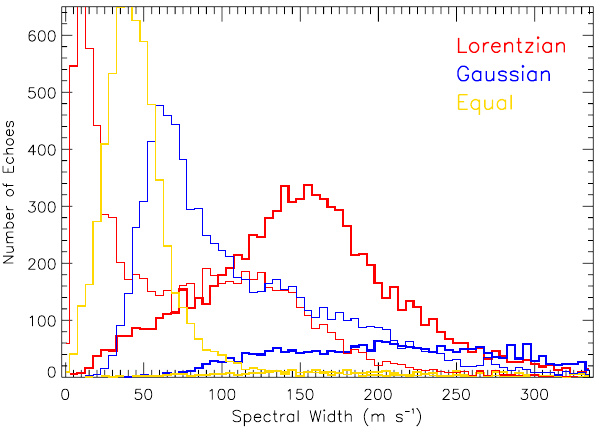
Fig. 4. Colour pixel maps showing the number of echoes versus 5-m s -1 bins of spectral width and for 45-km steps of group range relative to the location of the SWB during the interval, 12:15 to 15:00 UT on 10 December, 1999. The results have been sorted according to spectral fit type, (a) Lorentzian best fits, (b) indeterminate best fits, and (c) Gaussian best fits. The colour scale is proportional to the number of counts: black ( £ 5), purple (>5 to £ 15), …, red (>85).